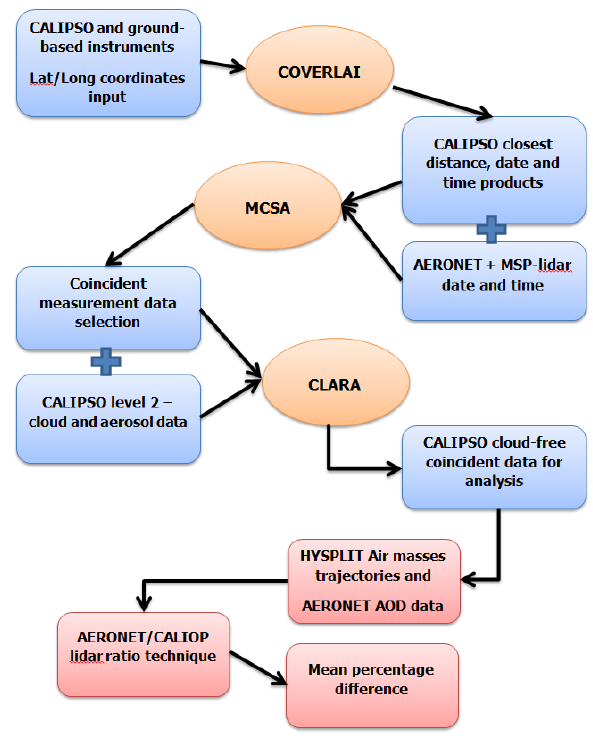
Fig. 2. Flowchart of the validation methodology and their output